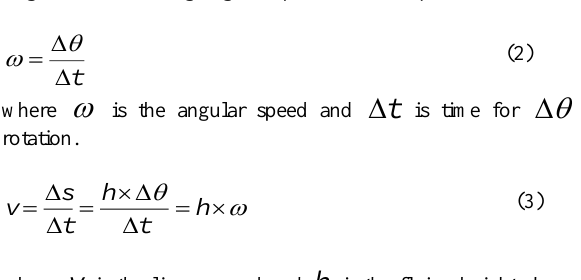
Figure 4. Converting angular speed to linear speed